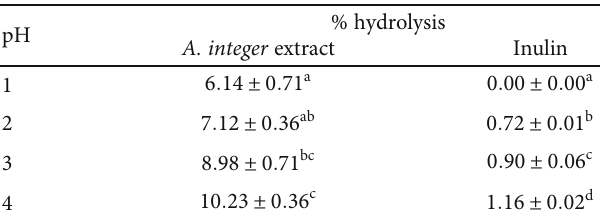
Table 8: Percentage hydrolysis by A. integer and inulin after gastric juice digestion in various pH.